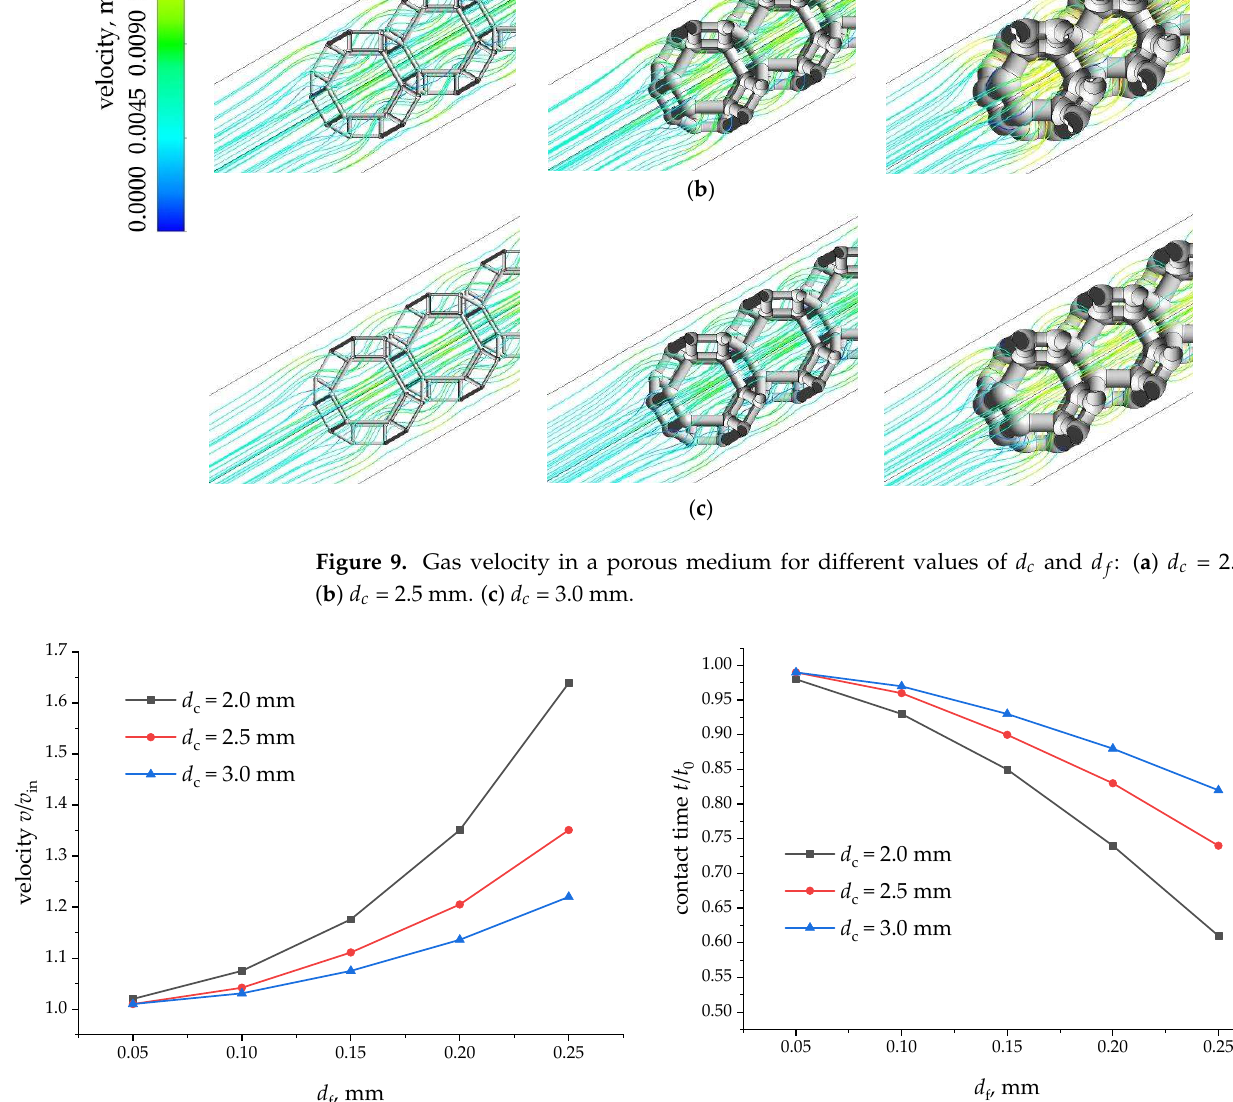
Figure 10. Parameters of gas movement in a porous medium: ( a ) Average gas velocity v / v in . ( b ) Average time of gas contact with the catalyst surface t / t 0